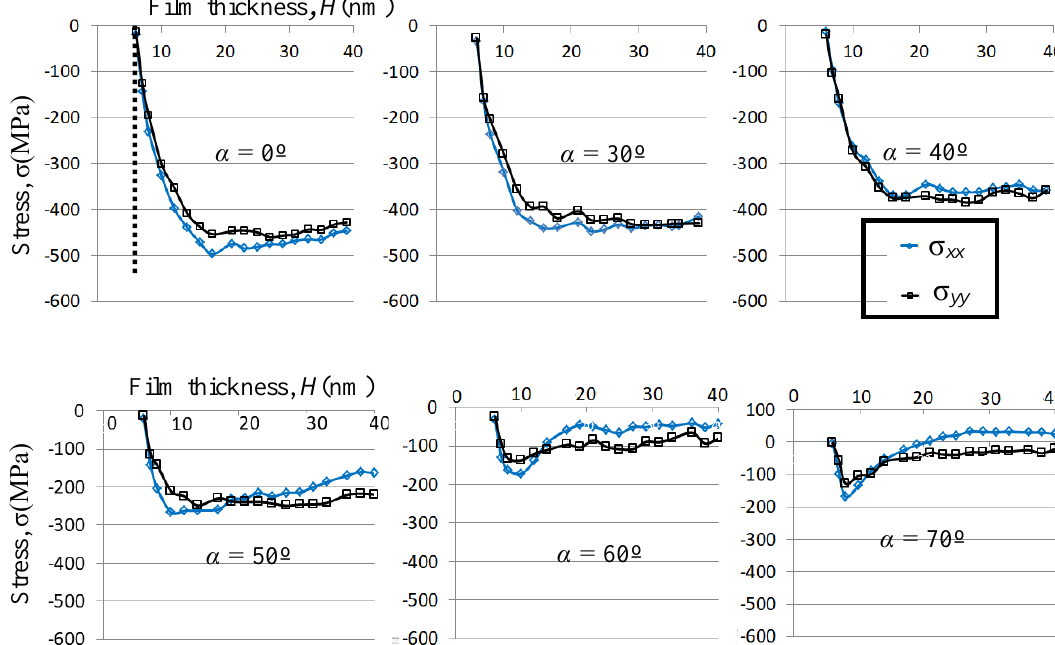
Figure 3. Dependencies of the stress tensor components σ xx(yy) on film thickness for different values of the deposition angle α. Vertical dotted line indicates the substrate boundary. Axis orientations are shown in Figure 2.